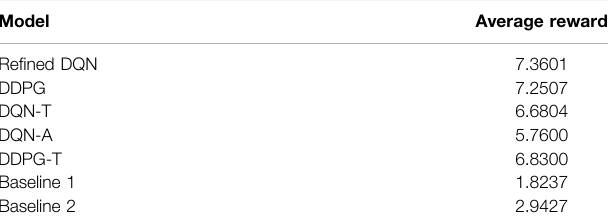
TABLE 2 | Average reward of different models.